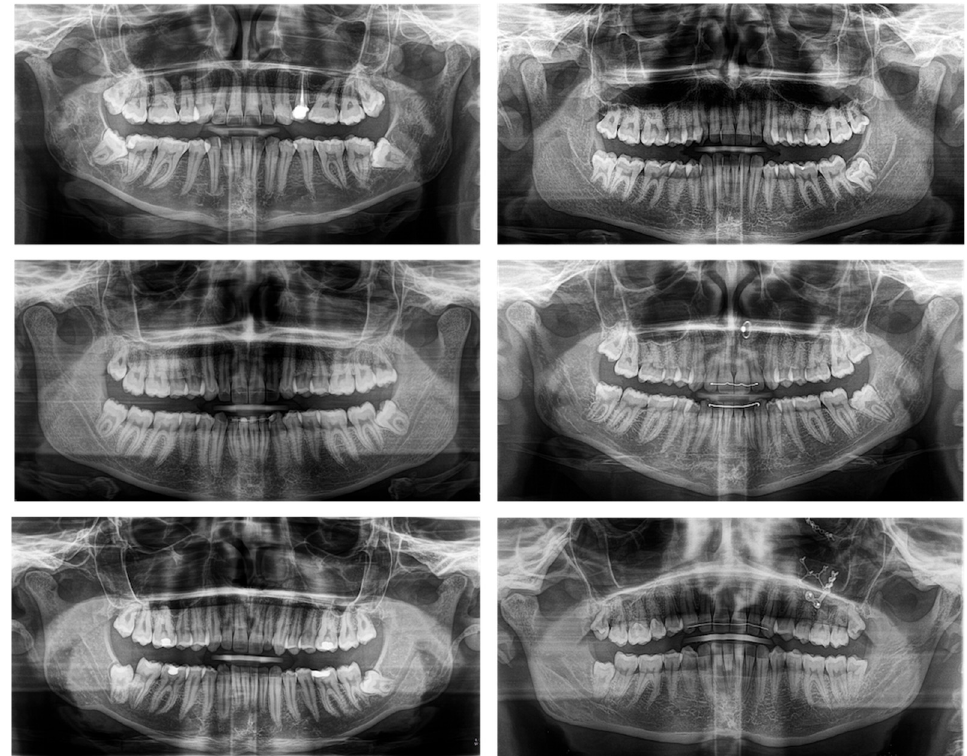
Figure 1. Study participants’ two-dimensional panoramic radiography (PAN) providing anatomical information about the angulation and position of the mandibular third molars (MTM) and the spatial proximity between the roots of the MTMs and the mandibular canal (MC). All participants showed an indication for the removal of MTMs and a close relationship between the MC and the MTM; therefore, these were considered high-risk cases and show indication for three-dimensional imaging.